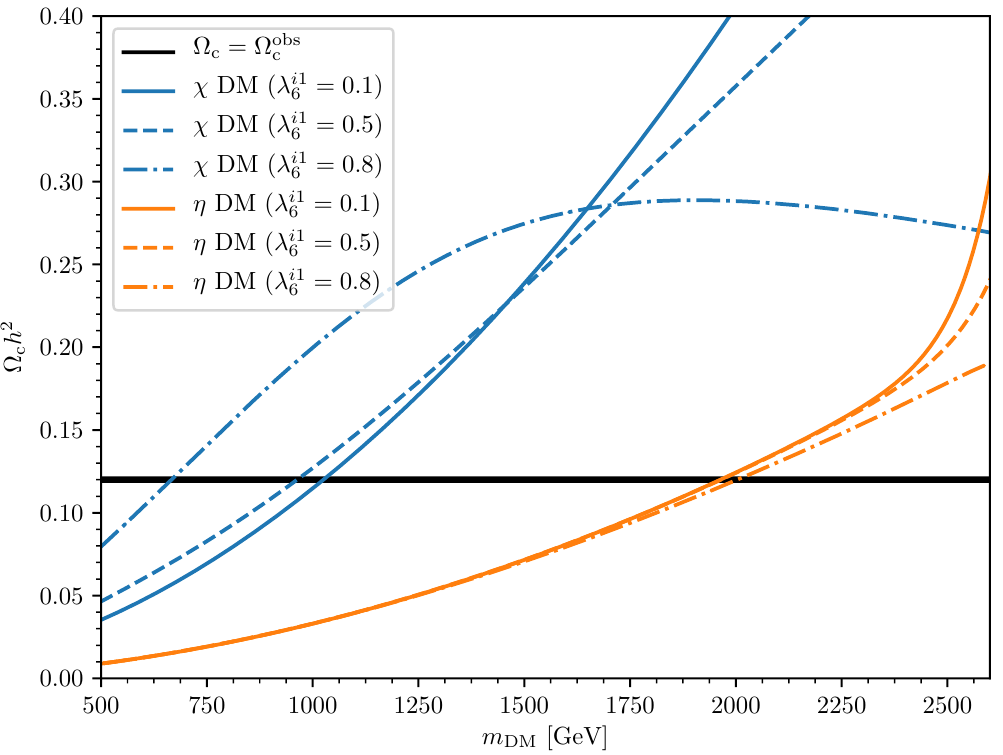
Figure 6 . The relic density as a function of the DM mass for singlet-doublet fermion ( (cid:31) 0 triplet scalar ( (cid:17) 0 ) DM. The used parameters are given in table 1